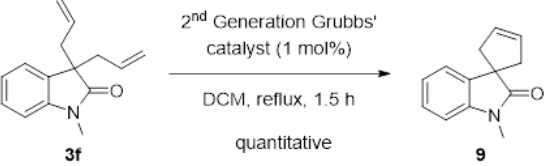
Figure 6 - Synthesis of spirooxindole 9 through a ruthenium- catalyzed metathesis